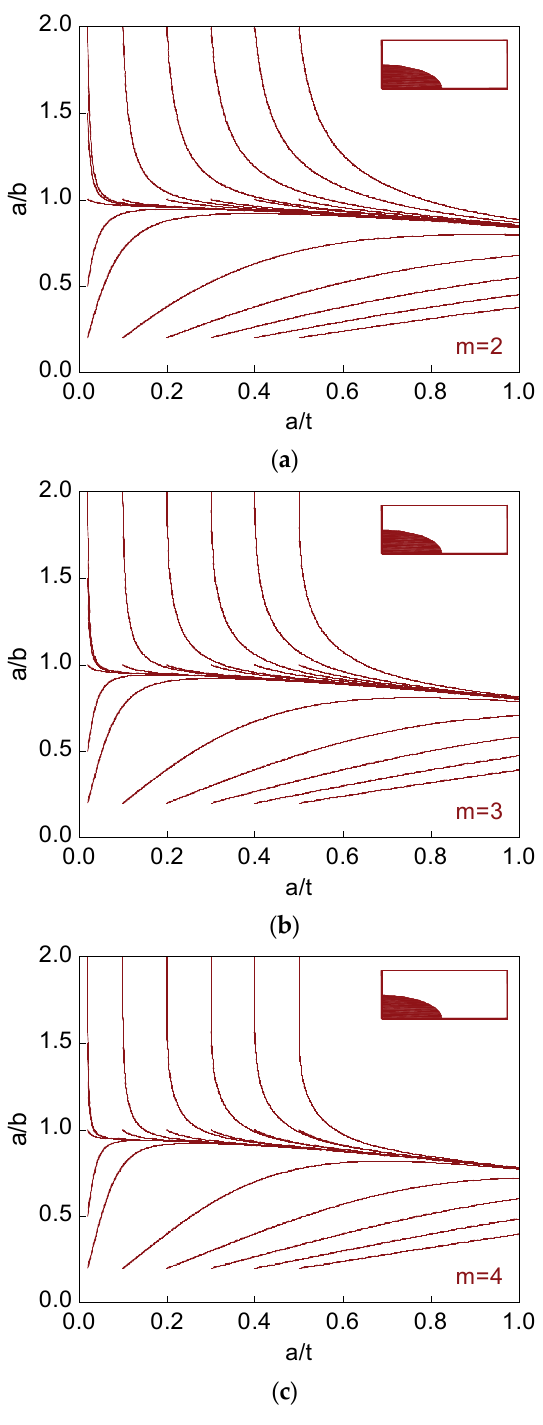
Figure 5. Aspect ratio evolution with relative crack depth (propagation path) for corner cracks: ( a ) m = 2; ( b ) m = 3; ( c ) m = 4.